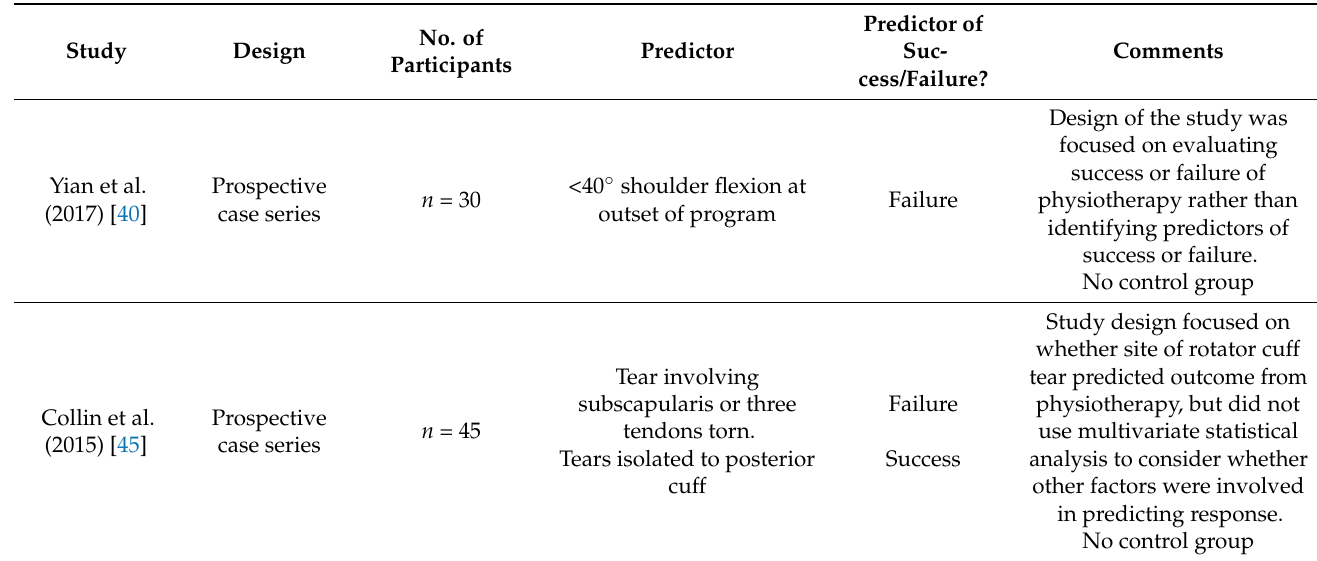
Table 2. Summary of studies identifying predictors of response to physiotherapy in